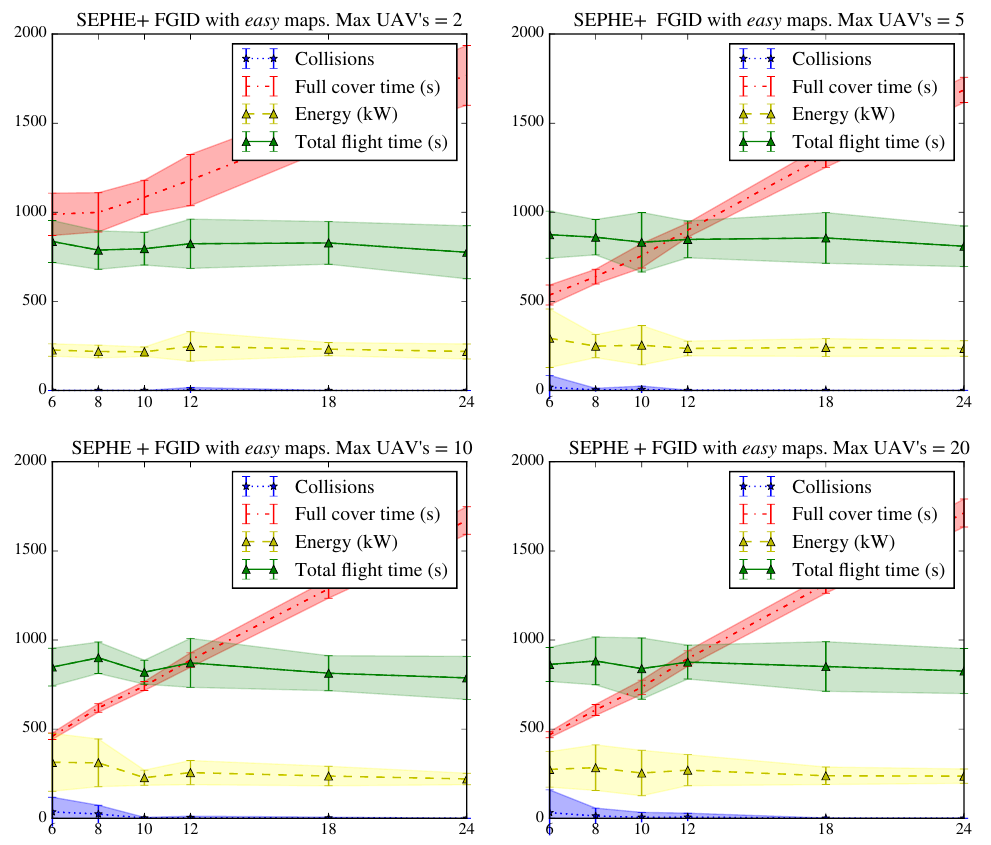
Figure 17. Results of the SEPHE behavior simulations for the FGID take-off strategy in an easy environment. The graph shows the average evolution and variation of the number of collisions, the time required to achieve 95% coverage, the energy consumed by the swarm, and the total flight time for 600 simulations (50 simulations on the same map for each combination of take-off time interval and maximum number of vehicles in